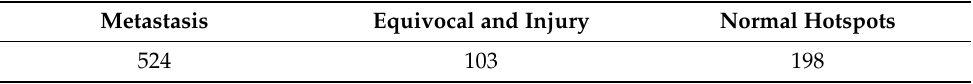
Table 1. The number of (a) metastatic lesions, (b) equivocal, injury, and (c) degenerative changes, and normal hotspots such as urine in the bladder, hotspots in the kidneys, etc. in 194 PC BS images.